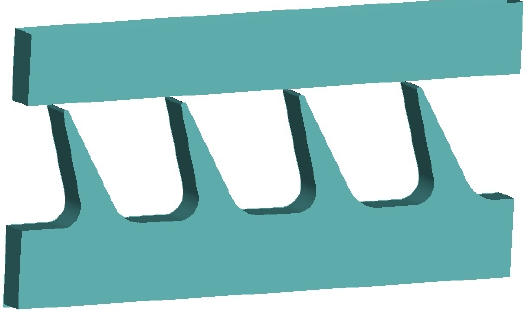
Figure 2. The application model.